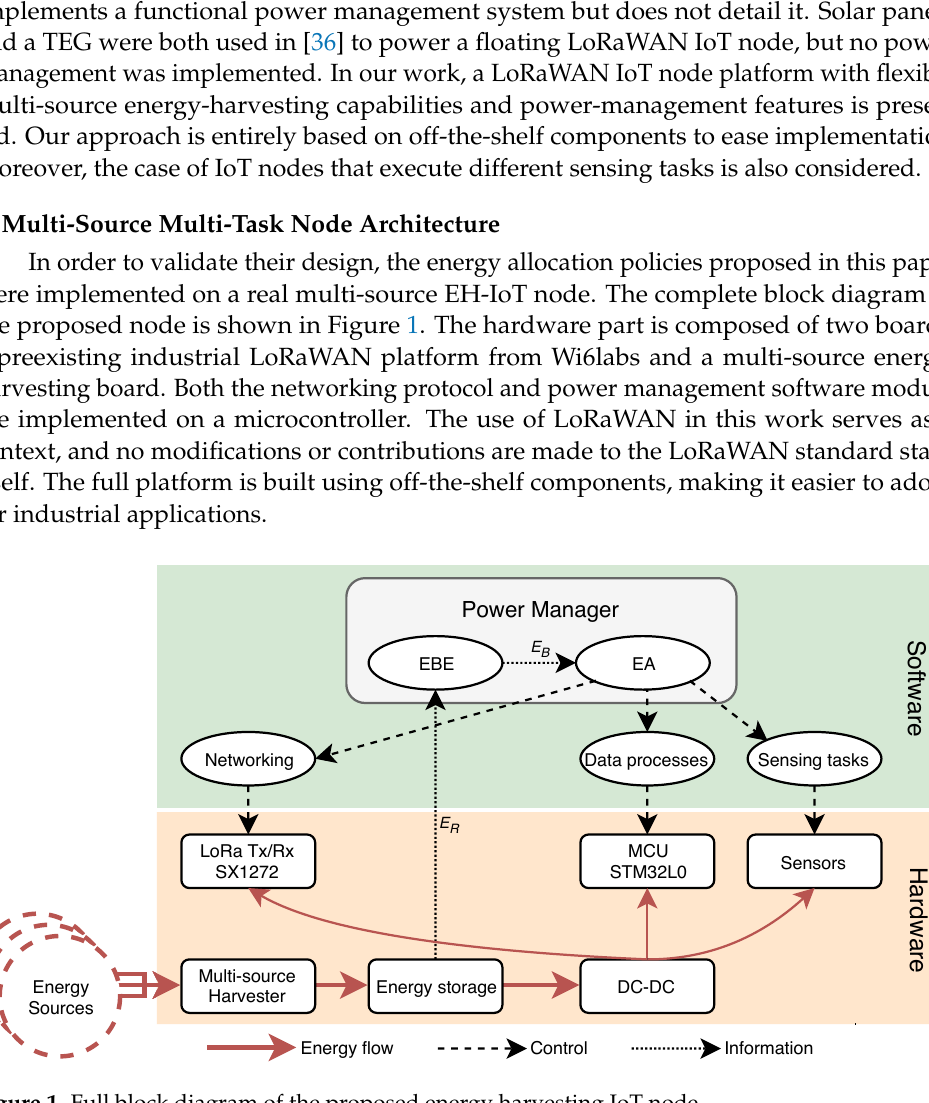
Figure 1. Full block diagram of the proposed energy harvesting IoT